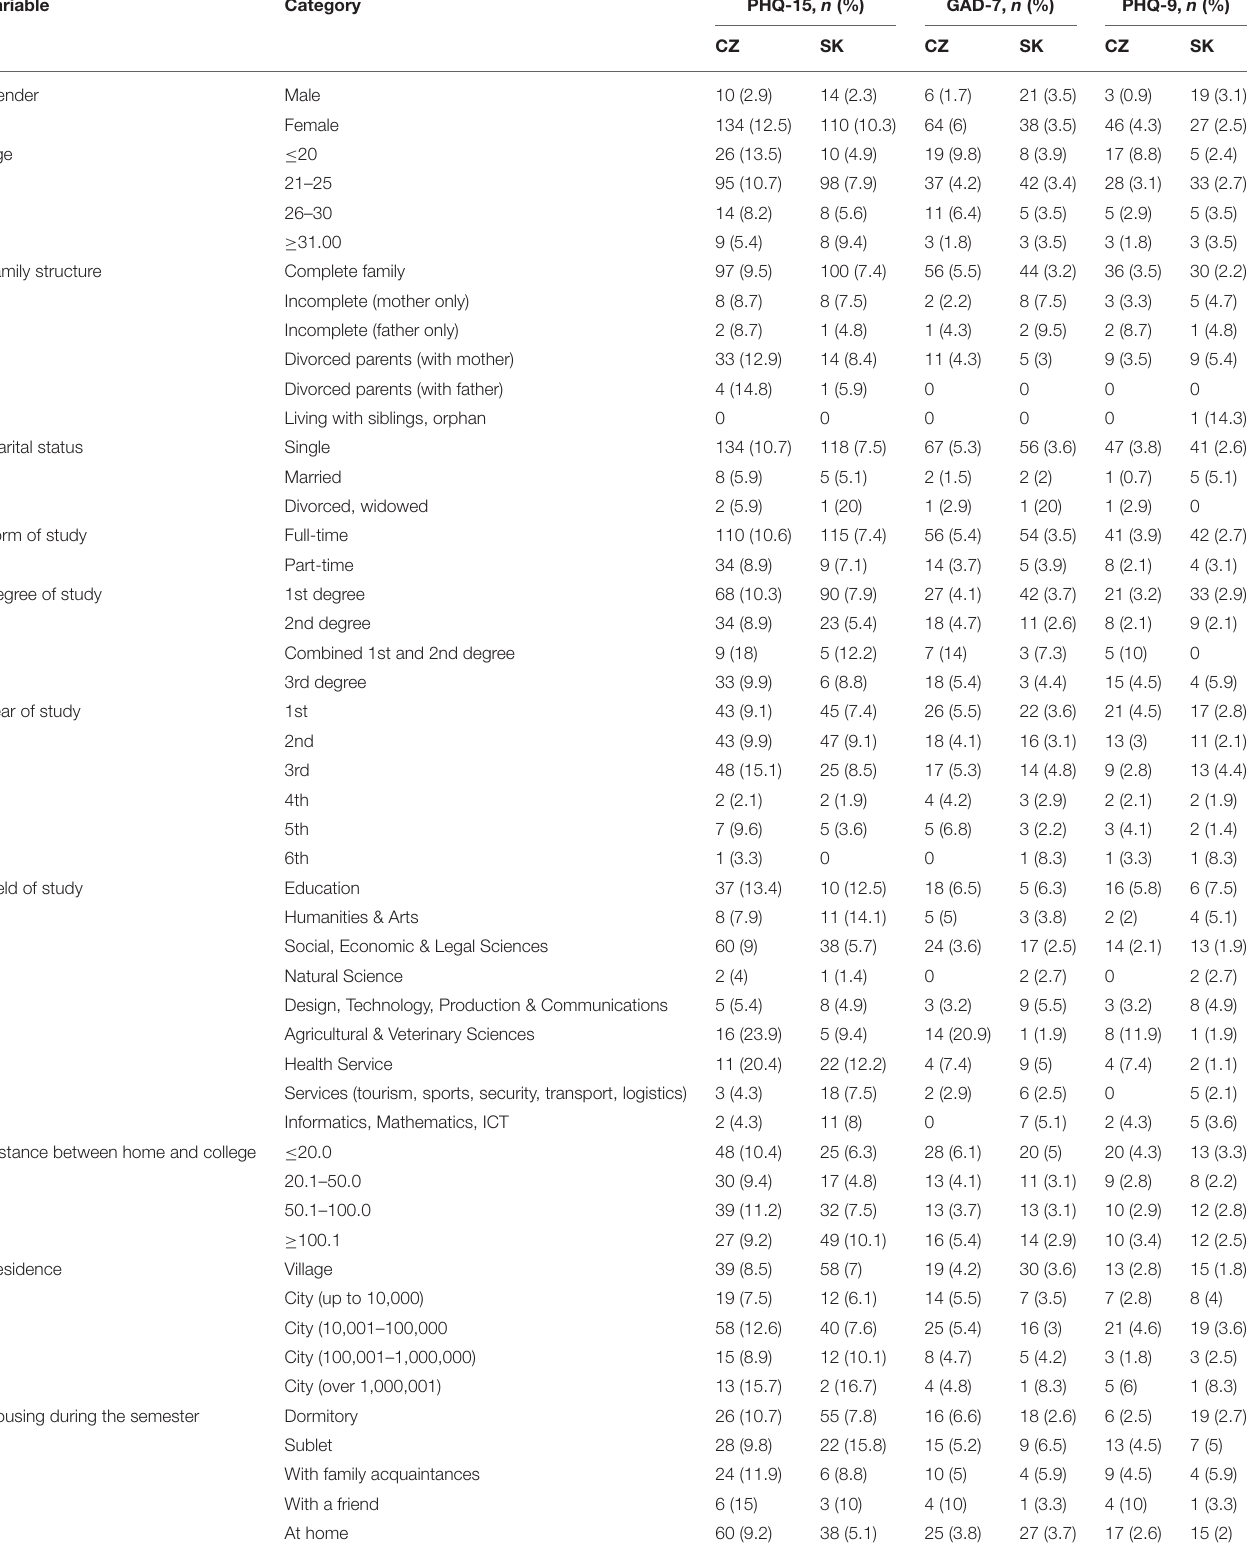
TABLE 2 | Proportion of severe mental health problems (PHQ-15, GAD-7, PHQ-9) in the classification of selected socio-demographic characteristics—frequency (percentage